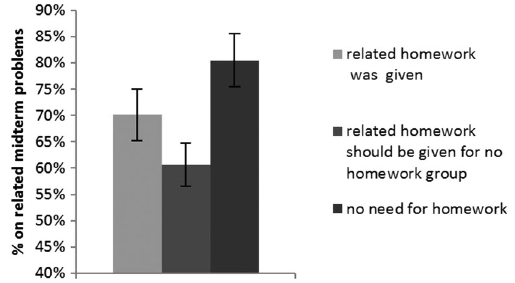
FIG. 6. Performance on related midterm